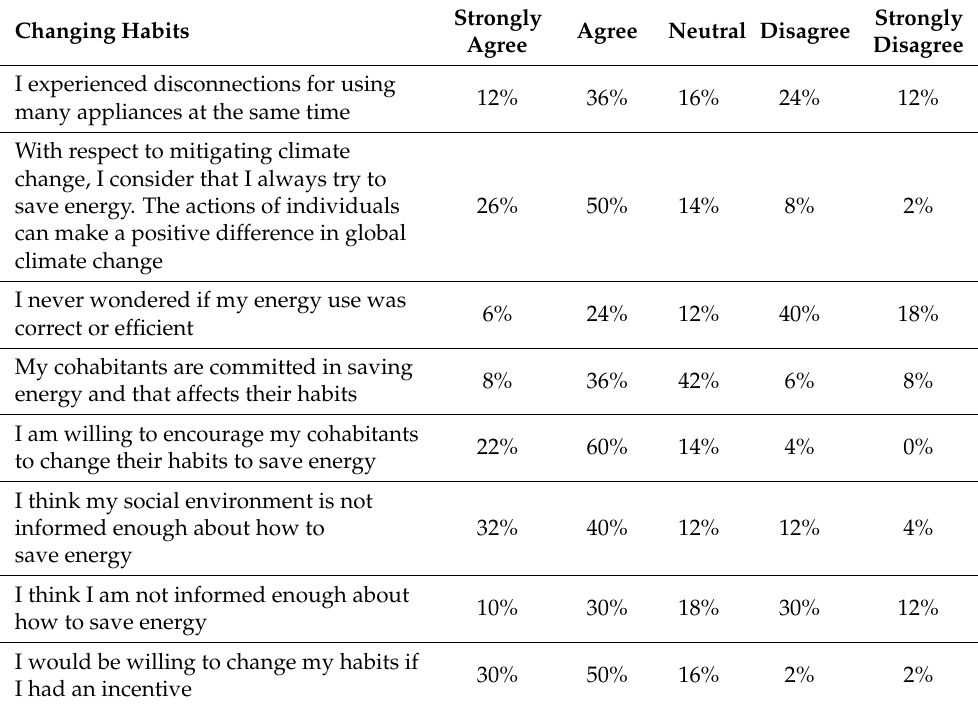
Table A2. Sentences about changing habits—answers collected on a 5-point Likert